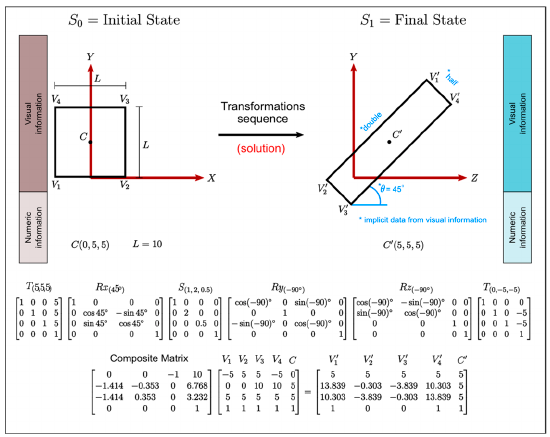
Figure 5. Revised learning exercise with restrictions in place.